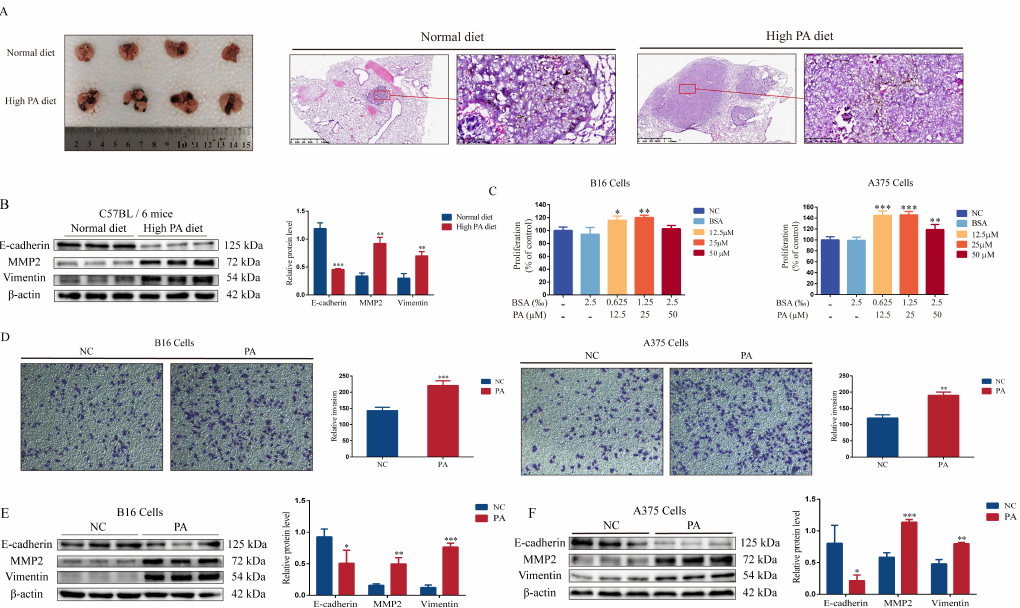
Figure 1. Palmitic acid promotes lung metastasis of melanomas. ( A ) Overall lung changes and HE staining after animal modeling (representative images). ( B ) The protein blots of E-cadherin, MMP2, Vimentin, and quantitative analysis from a mouse model. ( C ) The level of cell proliferation after B16 and A375 cells were incubated with PA for 24 h at different concentrations (12.5, 25, and 50 µ M). ( D ) The invasiveness of B16 and A375 cells. ( E ) The protein blots of E-cadherin, MMP2, Vimentin, and quantitative analysis from B16 cells. ( F ) The protein blots of E-cadherin, MMP2, Vimentin, and quantitative analysis from A375 cells. * p < 0.05, ** p < 0.01 or *** p < 0.001 compared with the control group; the significance of the t